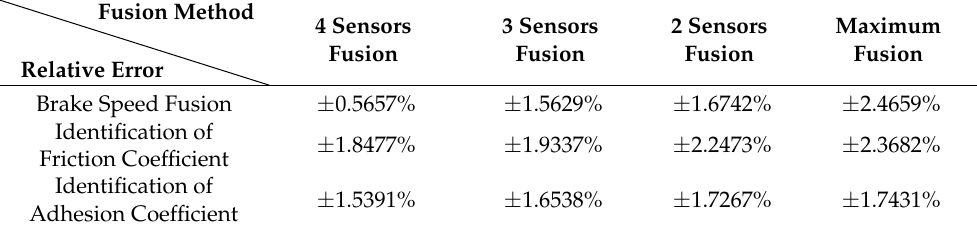
Table 5. Speed fusion errors and parameter identification errors.